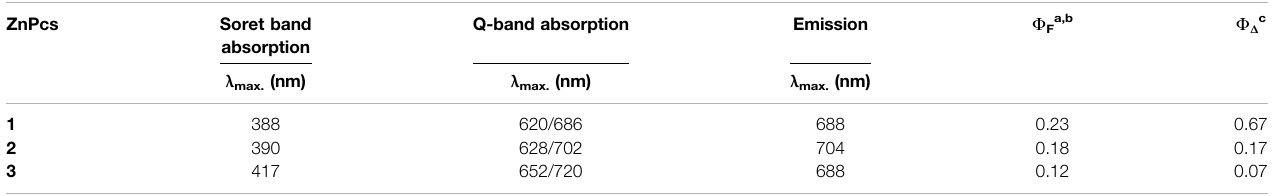
TABLE 1 | Photophysical properties of compounds ZnPcs 1 – 3 in DMF solutions. ZnPcs Soret band